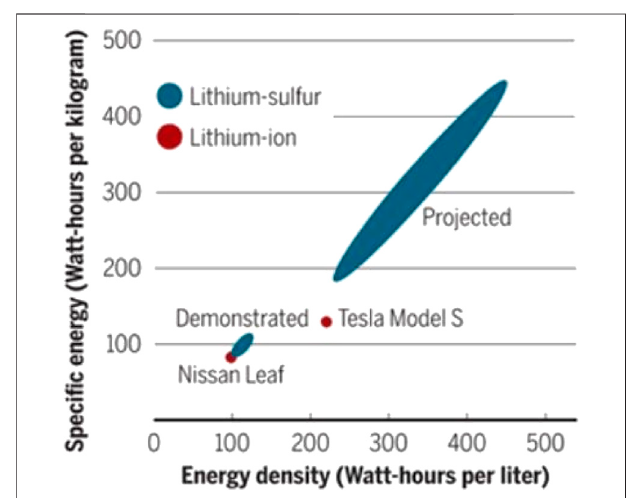
Frontiers in Mechanical Engineering |